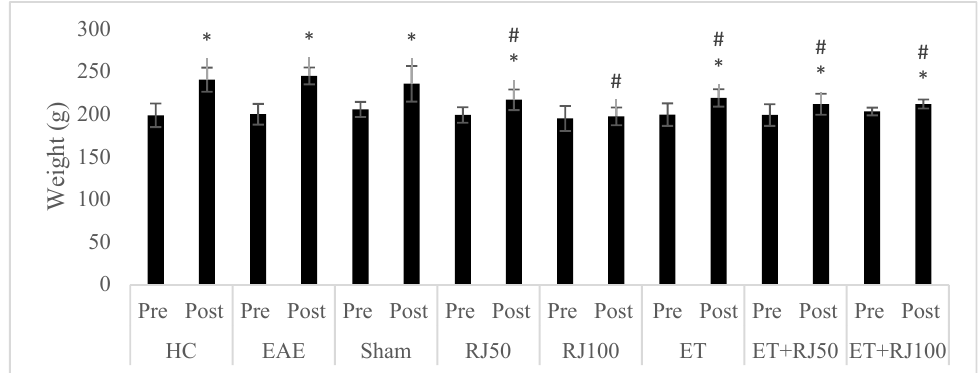
Figure 2. Comparison of weight pre- and posttreatment and with control group. * Significant difference with pretreatment. # Significant difference with HC. Healthy control (HC); experimental autoimmune encephalomyelitis (EAE); 50 mg/kg royal jelly (RJ50); 100 mg/kg royal jelly J (RJ100); exercise training (ET); exercise training + 50 mg/kg royal jelly (ET + RJ50); exercise training + 100 mg/kg royal jelly (ET + RJ100).